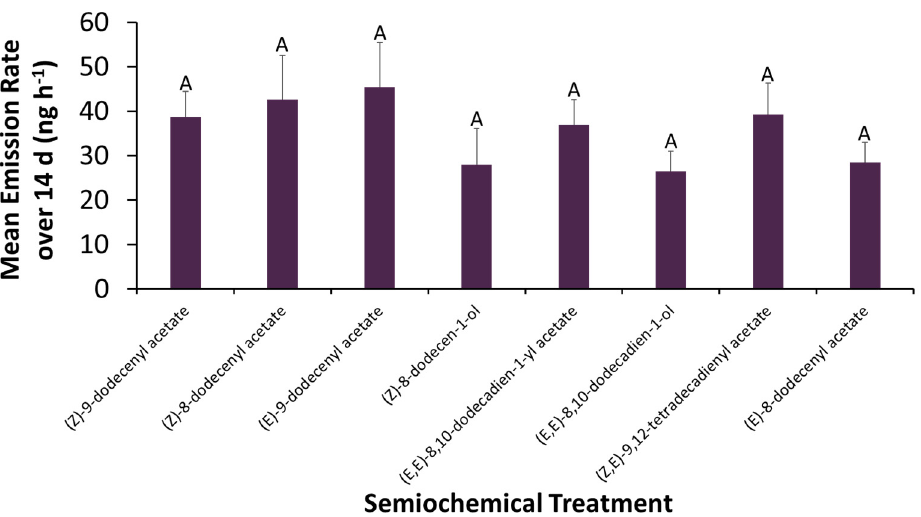
Figure 3. Mean volatile emission rates ( ± SE) by semiochemical lures used in the field baiting experiment after aging over average Salina, KS, USA, summer conditions in an environmental chamber (31.7 ◦ C, 68% RH) for a 14-d period and sampling at 1, 3, 5, 7, and 14 days with n = 3 replicates per compound and time point. Bars with shared letters are not significantly different from each other (Tukey HSD, α = 0.05). All lures reliably emitted semiochemicals over their period of use in the field in statistically similar amounts to each other.